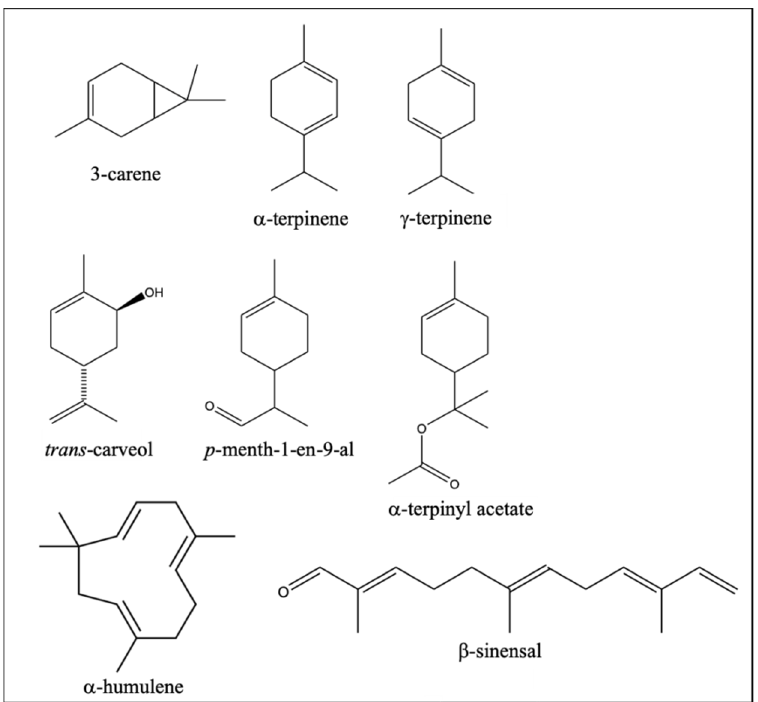
Figure 3. Identified monoterpenes and sesquiterpenes statistically more abundant in Clemenpons EO than in Clemenules EO, according to Table 1 ( p < 0.05, according to Student’s t -test, for each compound).